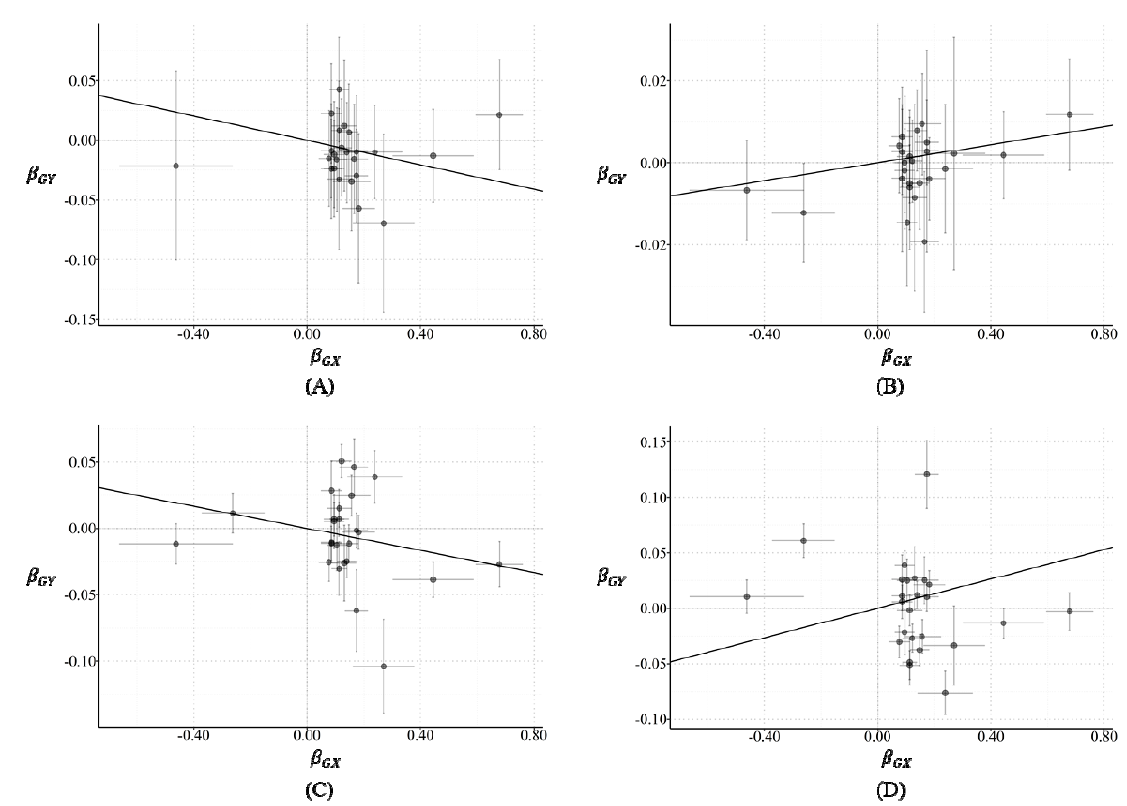
Figure 1. Scatter plots of the estimated effects of single nucleotide polymorphisms (SNPs) on rheumatoid arthritis (RA) against the estimated effects of SNPs on the risk of breast cancer. ( A – D ) are based on genome-wide association study (GWAS)-summary statistics for breast cancer in BBJ, BCAC, CIMBA-BRCA1 carriers, and CIMBA-BRCA2 carriers, respectively. β GX is calculated to estimate SNPs-RA association, and β GY is calculated to estimate SNPs-breast cancer association. The slopes of the lines are the estimated causal effects of RA on the risk of breast cancer, estimated using penalized robust inverse variance weighted (PRIVW) method.